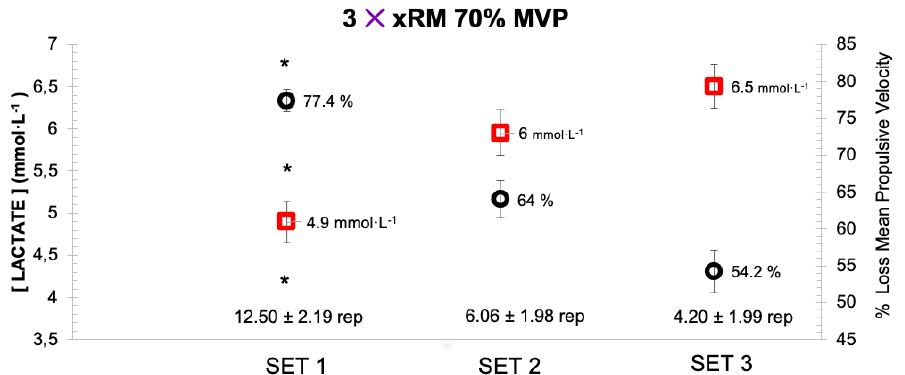
Figure 2. Comparison of the number of repetitions performed with velocity loss percentage and blood lactate level. * = significant difference between all sets ( p < 0.05).